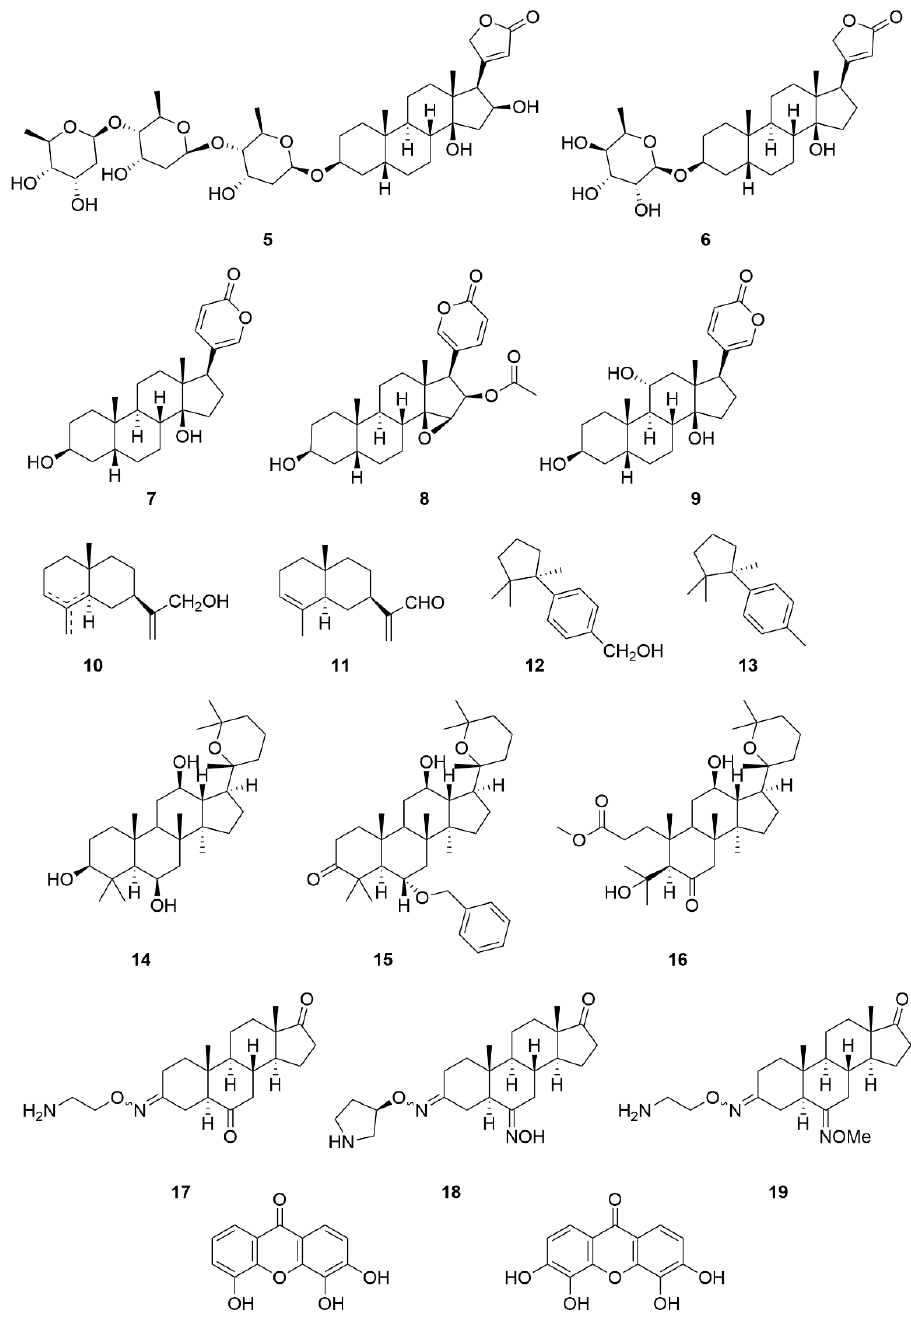
Figure 9. Chemical structures of selected cardiac steroids and related compounds 5–21 .